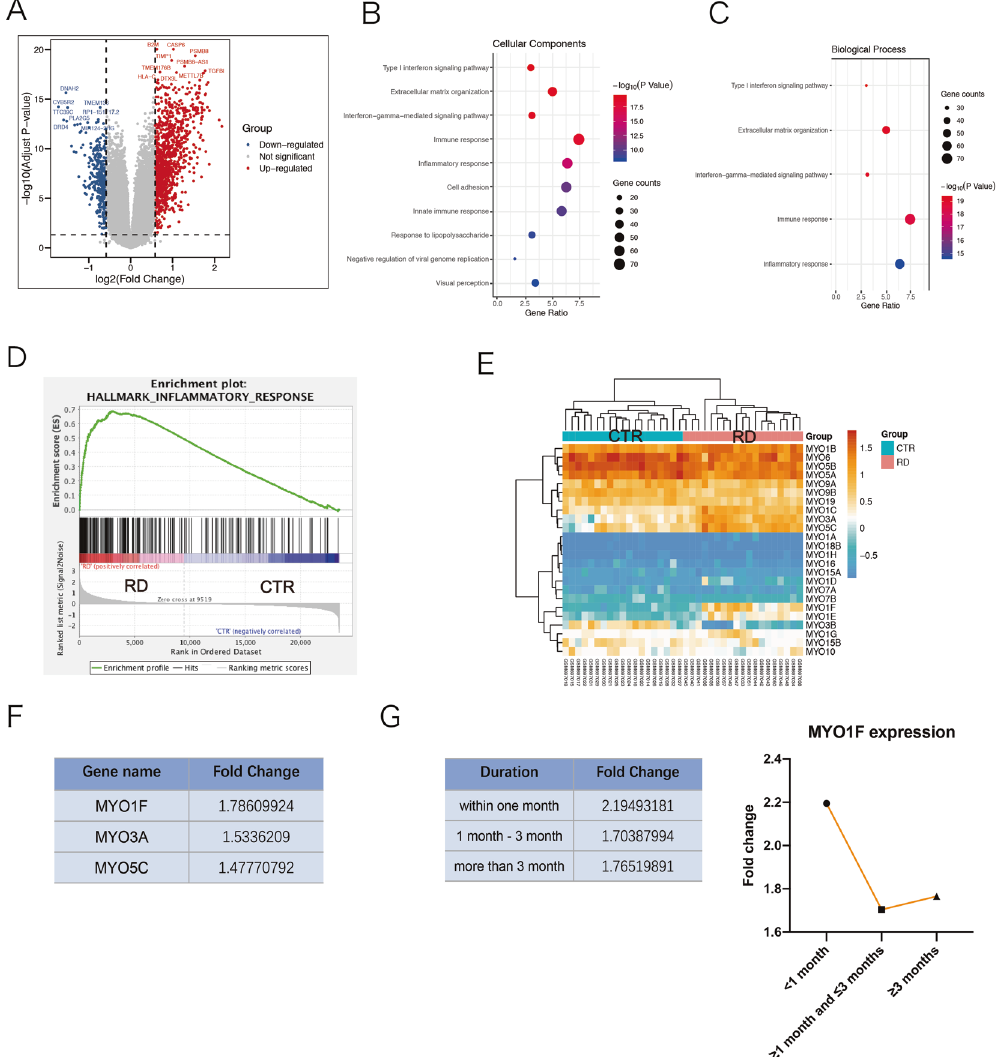
Fig. 1 Transcriptome analysis of human retinal detachment. A Identi fi cation of differential expressed genes (DEGs) were set as |FC | > 1.5 and P < 0.05. Red dots on the volcano plot ( A ) represent upregulated genes while blue dots represent downregulated genes. B , C Gene ontology analysis. Cellular components analysis ( B ) and biological process analysis ( C ) showed possible functions of DEGs. D Gene-set enrichment analysis (GSEA) also revealed possible pathways possibly correlated to RD, including in fl ammatory response. E , F Expression pattern of myosins. Heatmap ( E ) demonstrated the most evaluated myosin, myosin 1f, with a FC = 1.786 ( F ). G The fold changes of at different RD